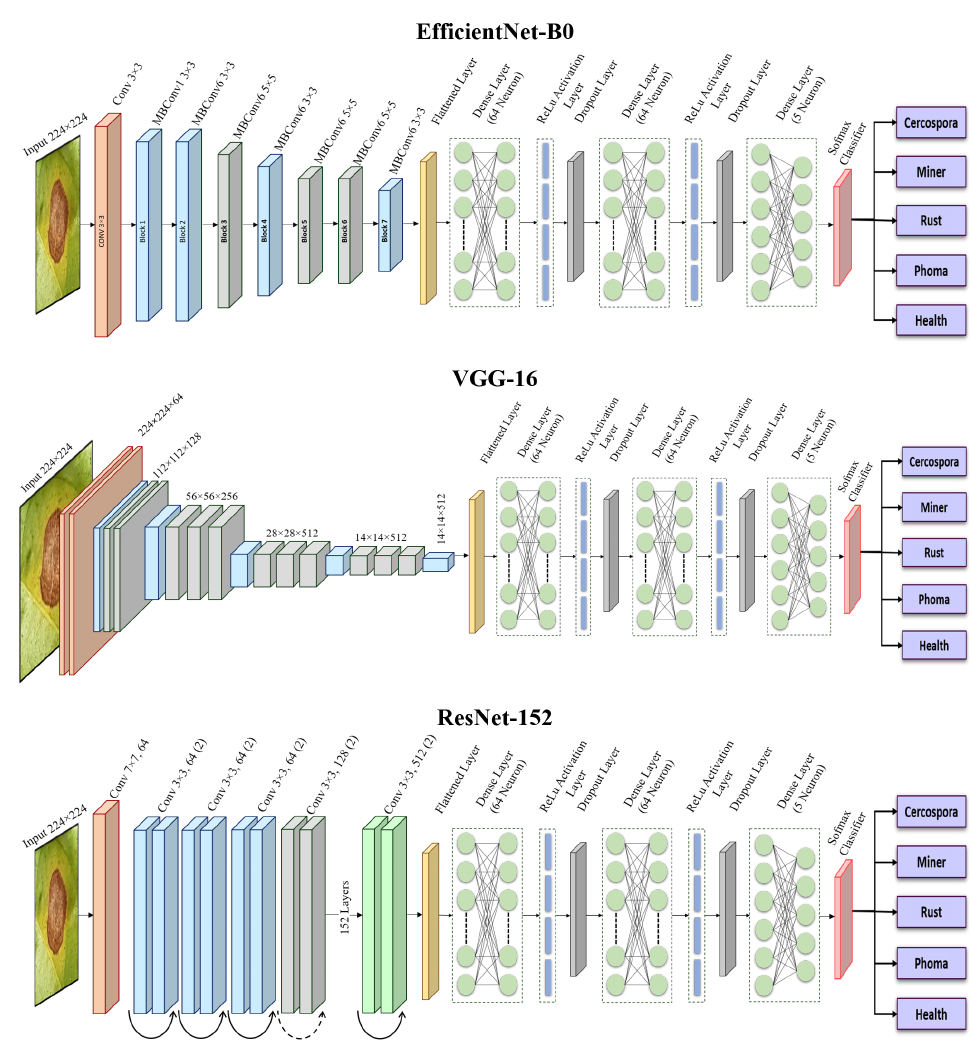
Figure 4. CNN base model architectures with proposed